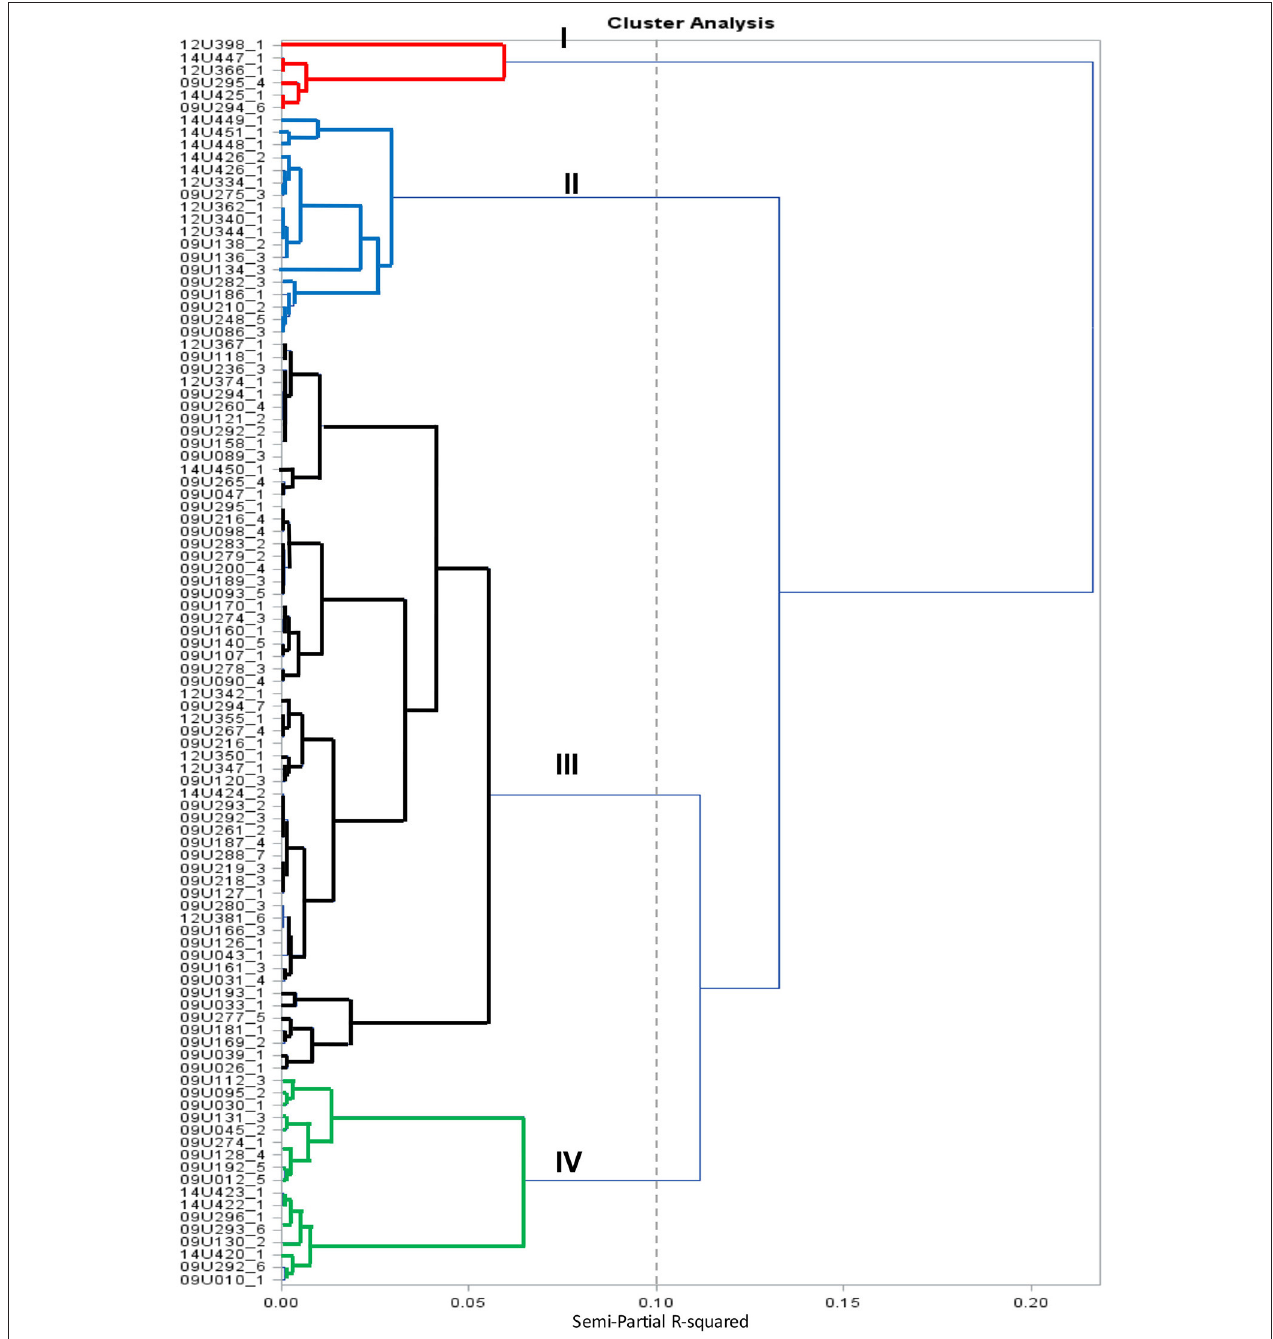
FIGURE 1 | Cluster dendrogram of cape gooseberry collection using 18 phenotypic traits based on Ward